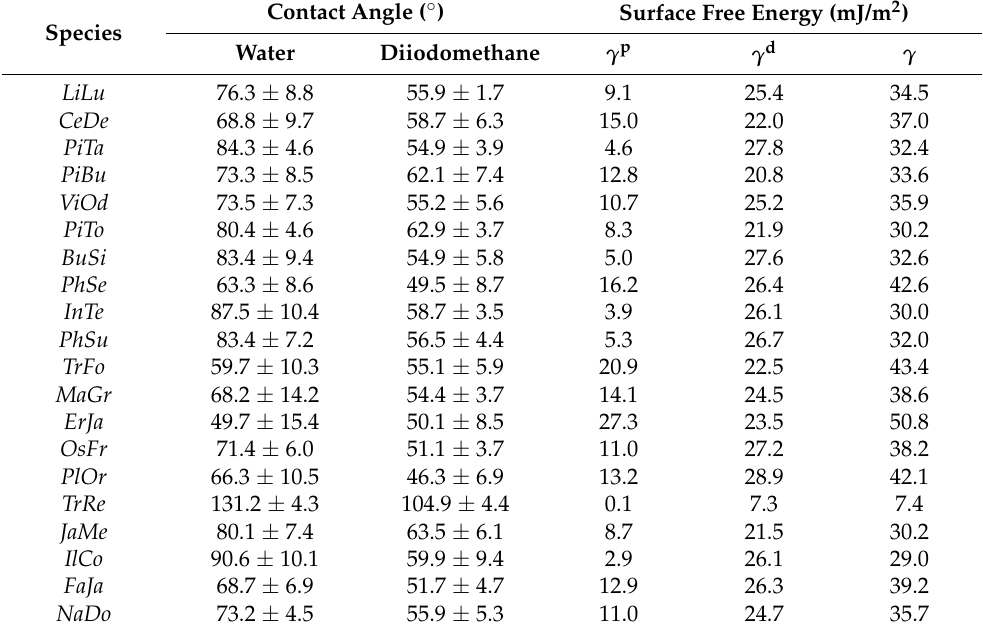
Table 2. Leaf surface wettability and surface free energy of plant